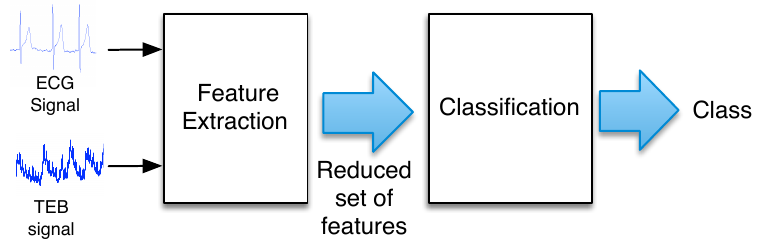
Figure 5. General scheme of the classifier.